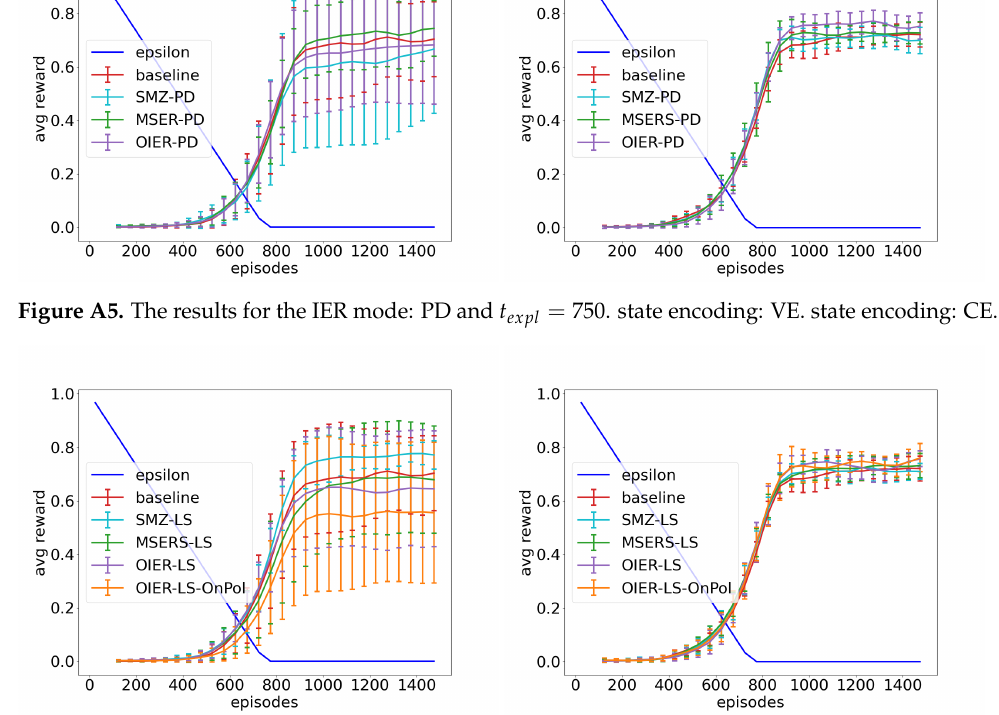
Figure A6. The results for the IER mode: LS and t expl = 750. state encoding: VE. state encoding: